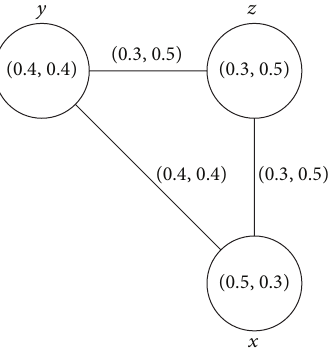
Figure 10: 𝐺 is complete but not